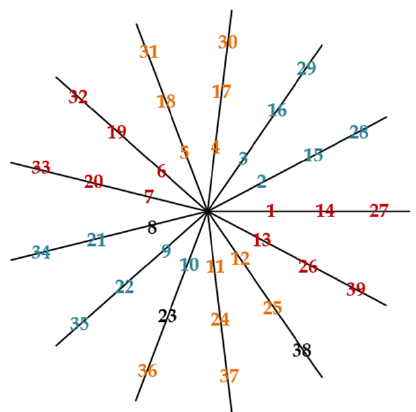
Figure 12. Star of slots diagram of the single − layer 3 − phase, 39 − slot, 6 − pole motor.